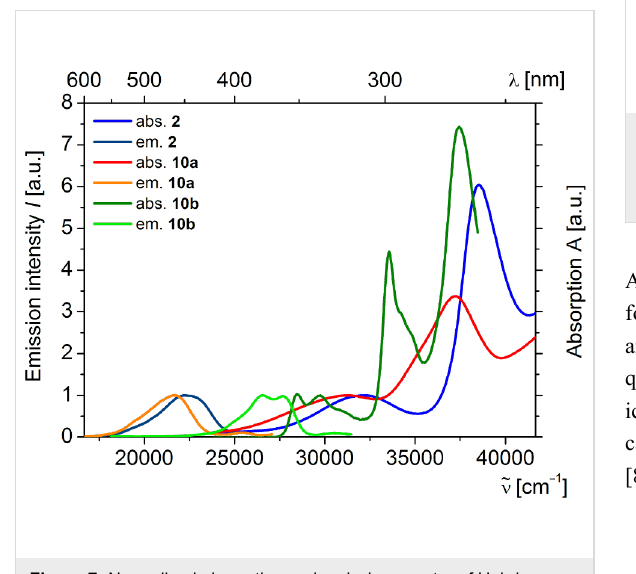
Figure 7: Normalized absorption and emission spectra of Ugi-donor compounds 2 and 10 (recorded in CH 2 Cl 2 , T = 298 K, λ max,exc ( 2 ) = 311 nm, λ max,exc ( 10a ) = 320 nm, λ max,exc ( 10b ) = 298 nm).